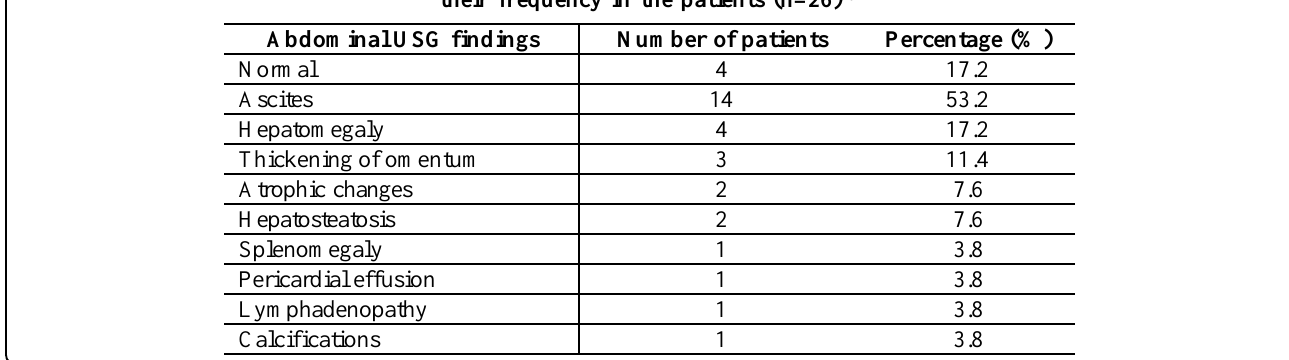
Table VI : Abdominal ultrasonographic findings (may be more than one in each patient) and their frequency in the patients (n=26)